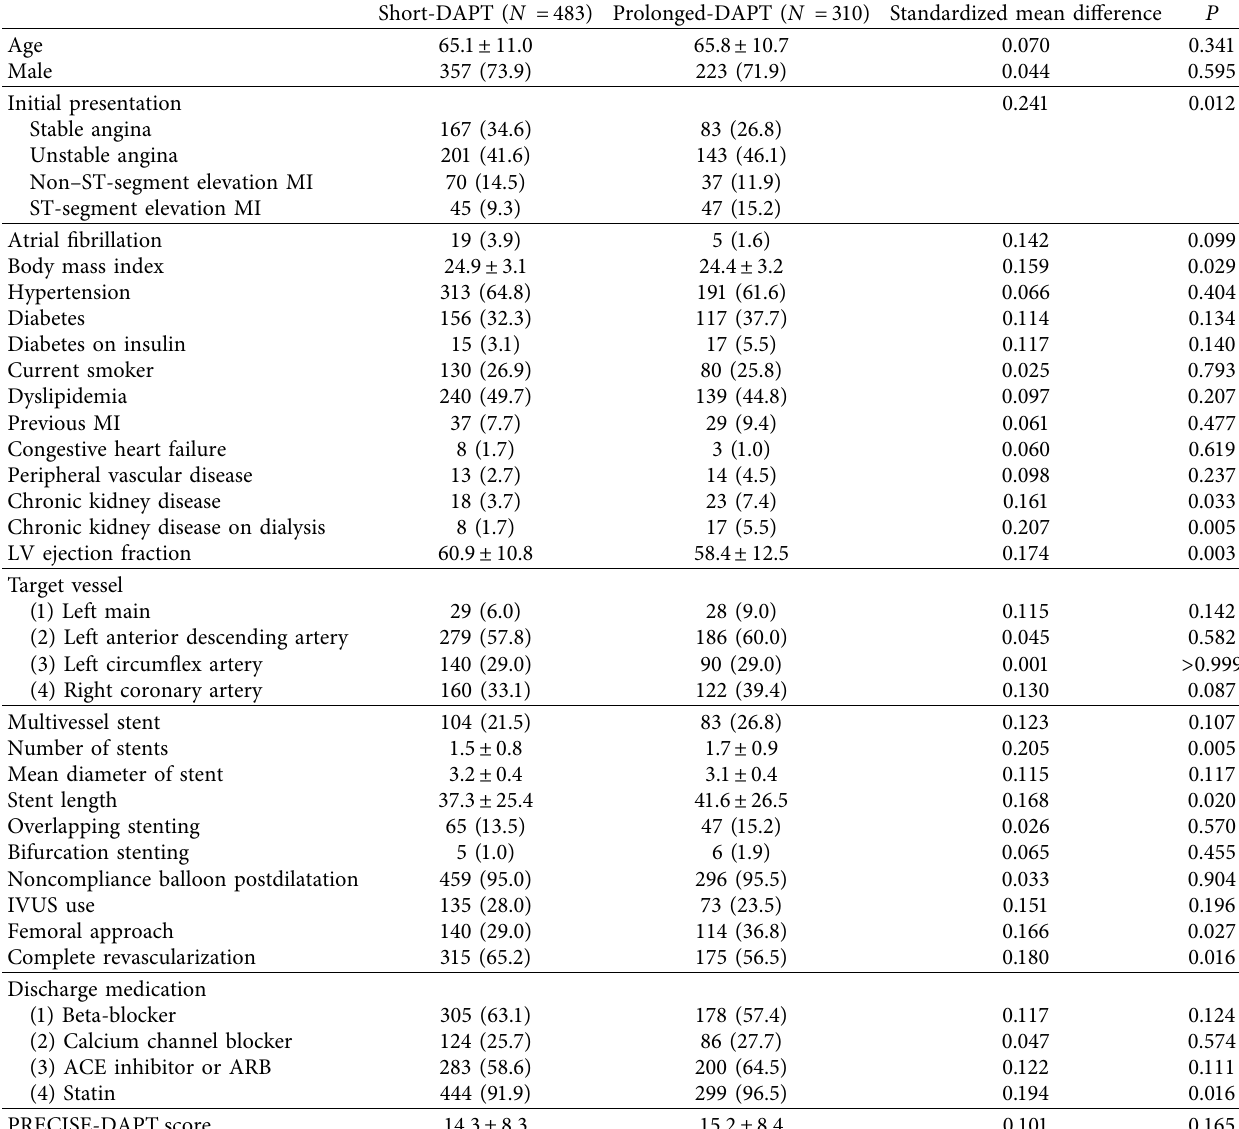
Table 1: Baseline characteristics in the total